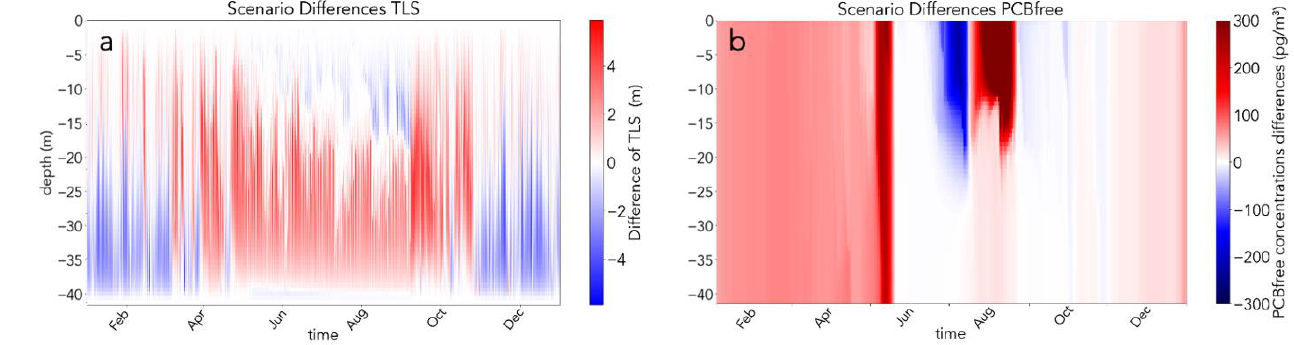
Figure 15. Differences between tide – no-tide scenarios for SNS region: ( a ) in turbulence length scale; ( b ) in PCB free concentration. ( b ) in PCB free